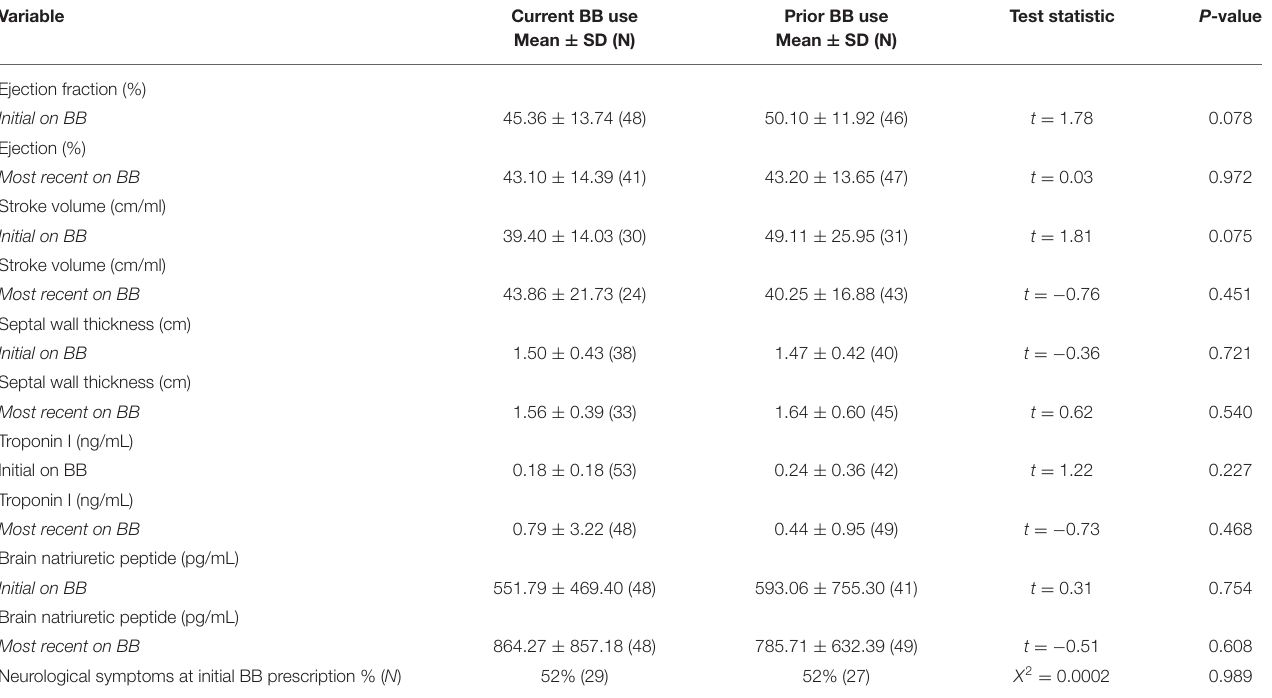
TABLE 4 | Cardiac and neurologic variables by current and prior beta-blocker (BB)